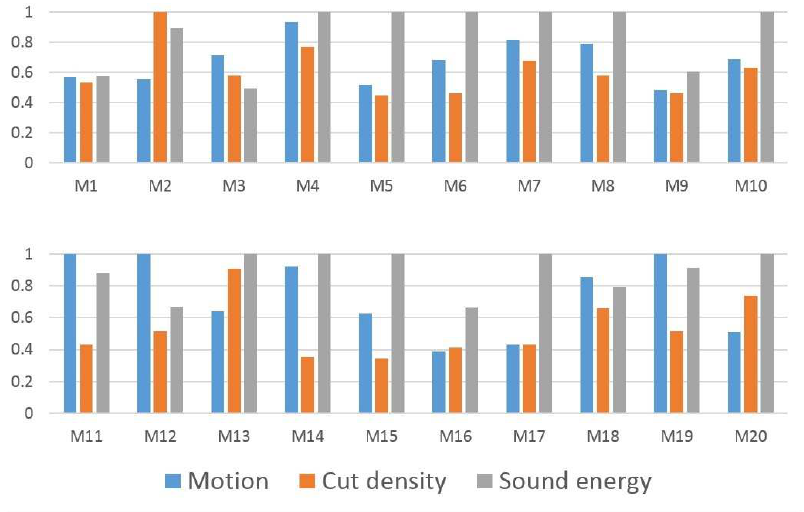
Figure 7. The global sensitivity feature values of 20